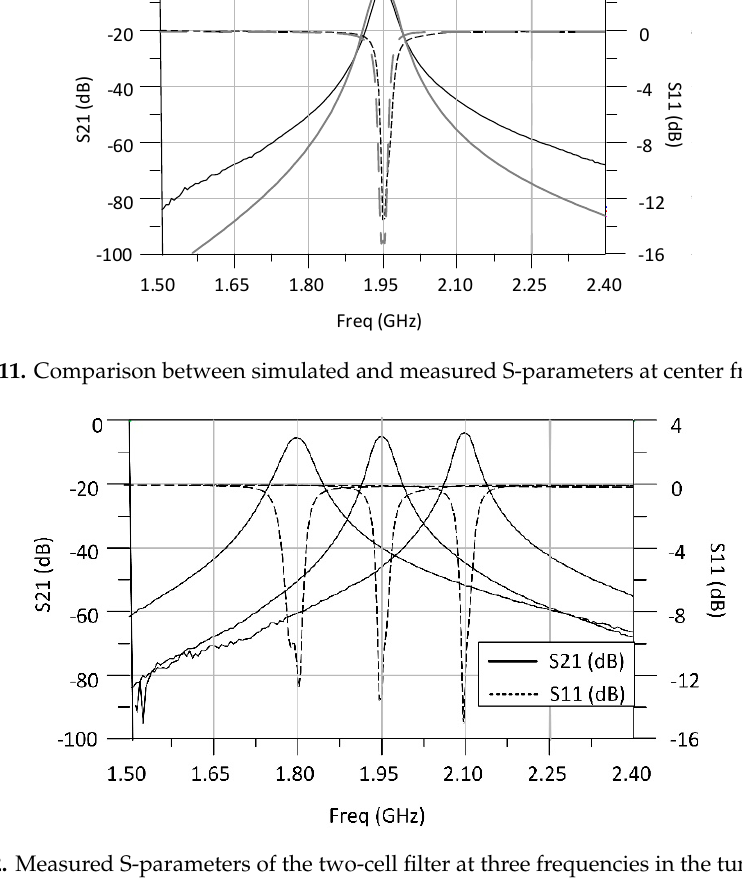
Figure 12. Measured S-parameters of the two-cell filter at three frequencies in the tuning range.